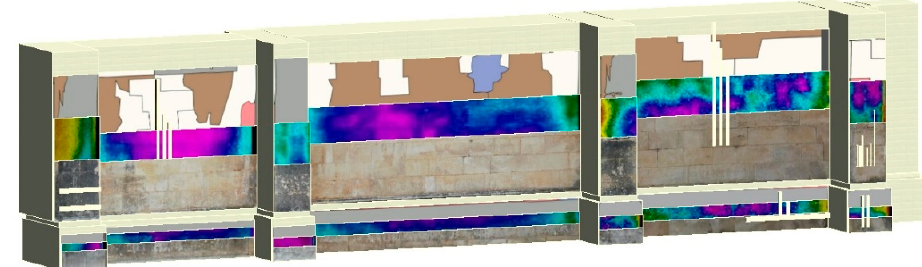
Figure 15. Images and maps on the bottom part of the chapel façade integrated in the BIM model.